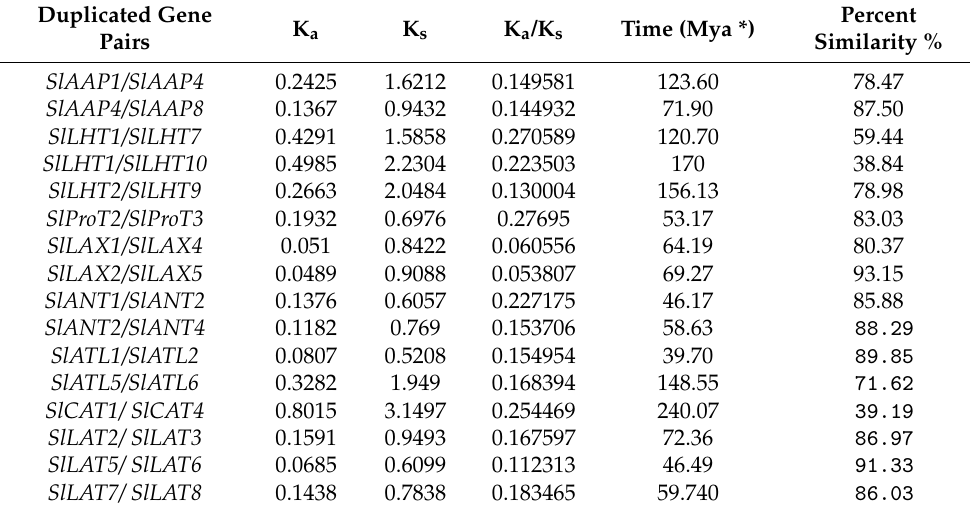
Table 2. The gene duplication data obtained from the Plant Genome Duplication Database (PGDD). Duplicated Gene